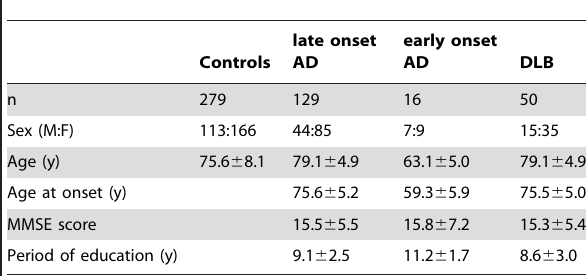
Table 1. Subject background.